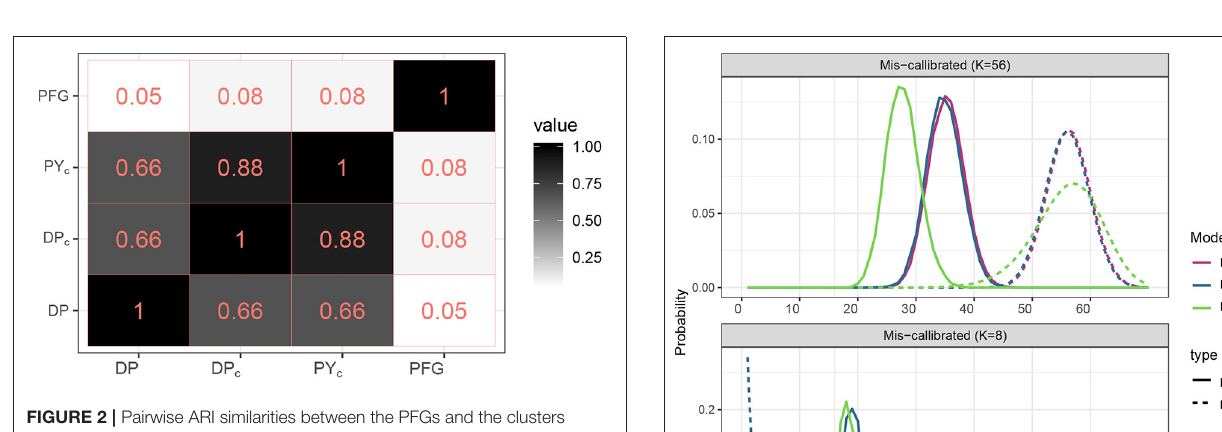
FIGURE 1 | Prior distribution and posterior estimation of the number of clusters corresponding to DP , DP c , PY c models. For DP c and PY c models, prior distribution is specified such that E [ K S ] matches the prior ecological knowledge (in our case it is the number of PFGs). Posterior estimation for all the models is represented by the posterior distribution of the number of clusters (solid lines) and the number of clusters of the posterior cluster estimate (points on x-axis). Refer to the clustering estimation procedure described in Supplementary Material , section S.7 for a pointer on why the size of the cluster estimate can be distant from the bulk of the posterior distribution.